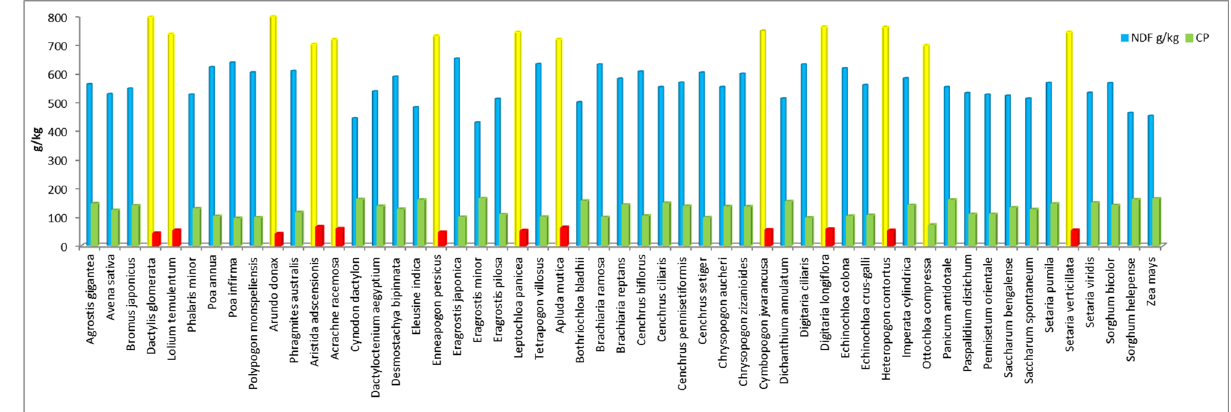
Figure 1. Comparative illustration of the CP and NDF contents of ethnobotanical grasses (Yellow NDF bars showing above critical value > 650 g/kg while red CP bars showing below critical value < 70 adscensionis > Apluda mutica > Acrachne racemosa > Digitaria longiflora > Cymbopogon jwarancusa > Lolium temulentum > Setaria verticillata > Heteropogon contortus > Leptochloa panacea > Enneapogon persicus > Dactylis